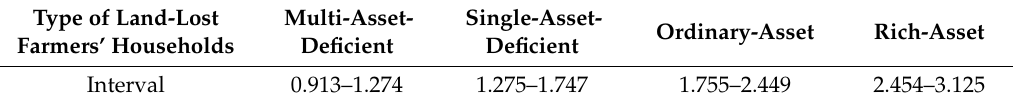
Table 5. Classification and statistics results of landless households based on total assets of farmers’ livelihoods.